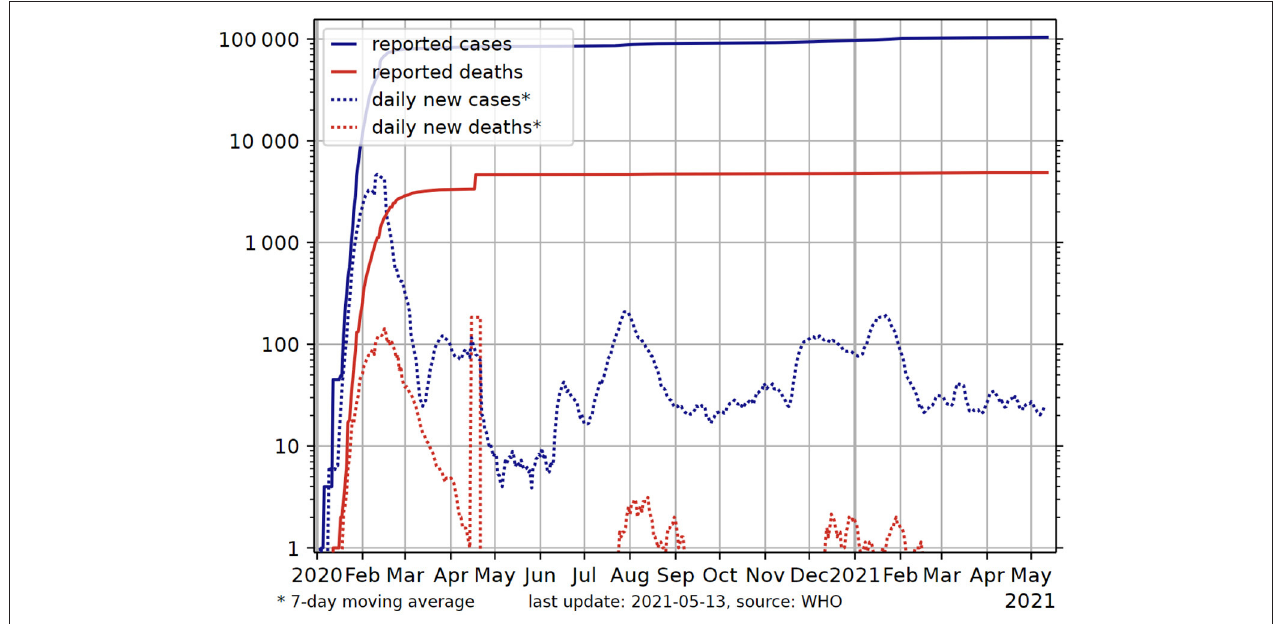
FIGURE 7 | Total confirmed cases and deaths in China from early 2020 to date. Source: World Health Organization (29).